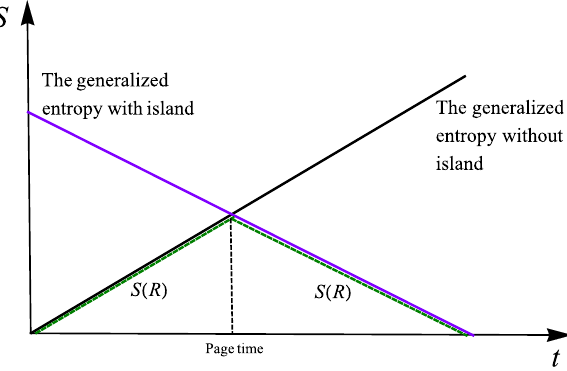
Fig. 1 The Page curve, described by the green dashed line, for the black hole evaporation consistent with the unitarity evolution